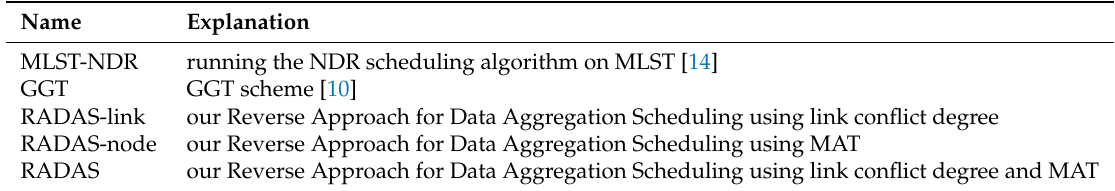
Table 3. Evaluation